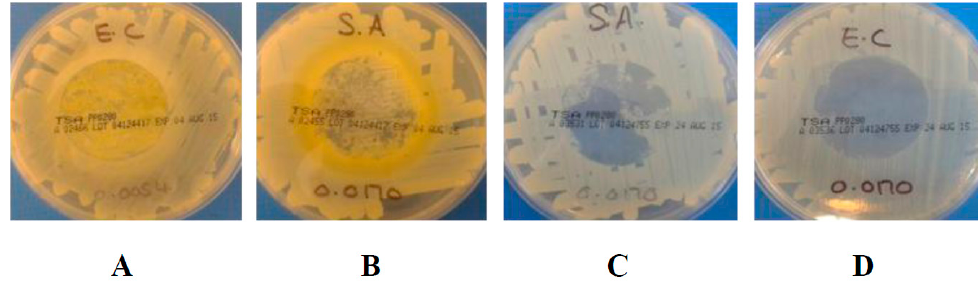
Figure 2. Examples of bacteria growth under either MH- or MGO-coated nonwoven samples. A = heavy growth of E. coli ; B = medium growth of S. Aureus ; C = slight growth of S. aureus and D = no growth of E. coli . Note: all coated samples were 3 cm in diameter.